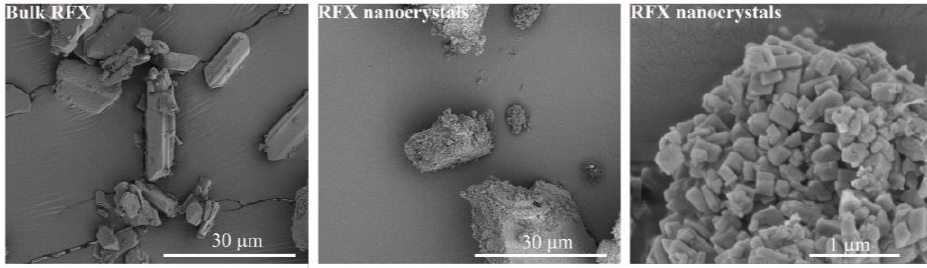
Figure 2. SEM images of bulk RFX ( left ) and nanocrystalline RFX (( middle ) and ( right )).